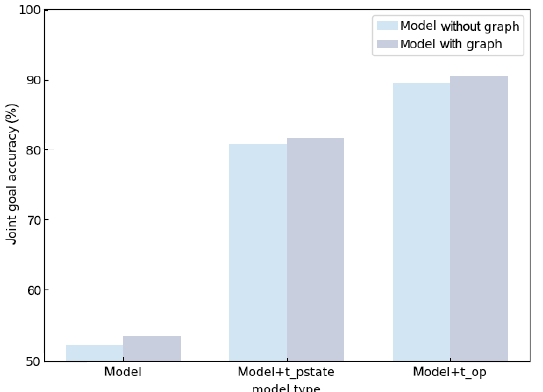
Fig. 4 Effects of different module outputs on model